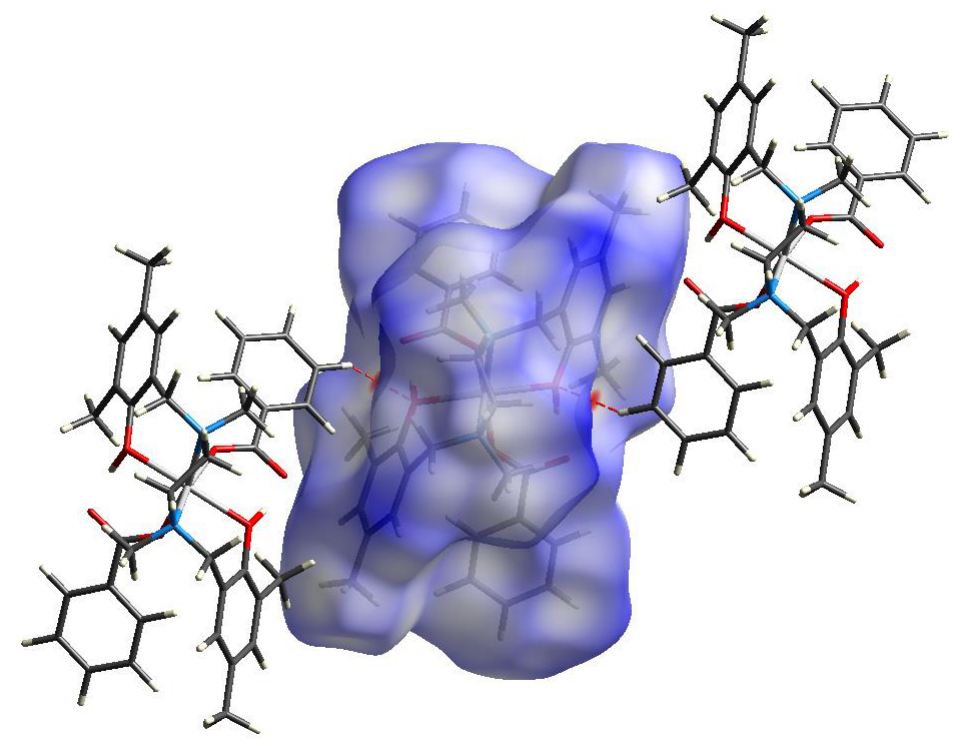
Figure 5. Hirshfeld surface analysis of complex 1 (red contours indicating close contacts).